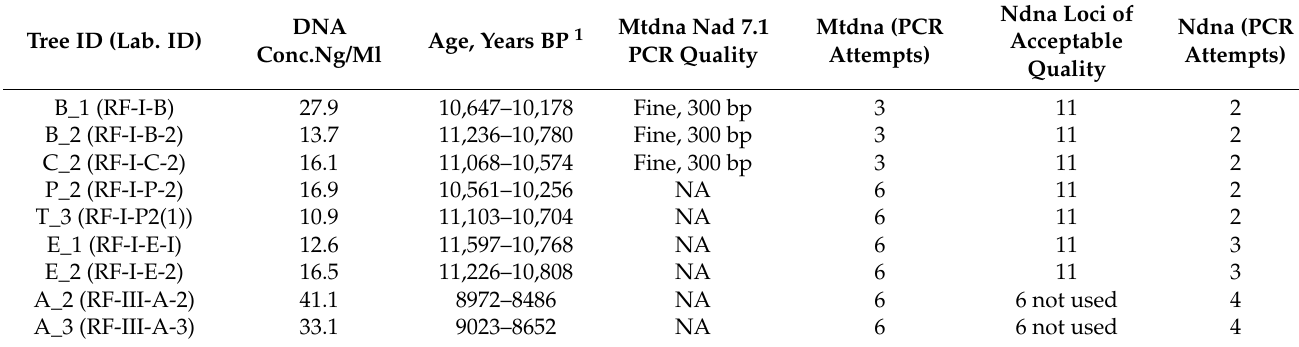
Table 2. Characteristics and summary of the DNA testing success of the ancient underwater individuals of Scots pine (details on the PCR quality at the microsatellite loci are given in the Table S1). “PCR attempts” are the number of independent PCR runs (sampled from the “maternal” extracted DNA sample). “Fine” means PCR fragments above 50 relative florescence units (RFU) found at least in two replications (RFU rages from 0 to 6000, where all DNA fragments below 10 RFU is set as noise). NA means no amplification. “Not used” means not used in the analysis. RF codes refer to the sea sampling site according to [21]. Original lab tree ID is given in the brackets for reference with other